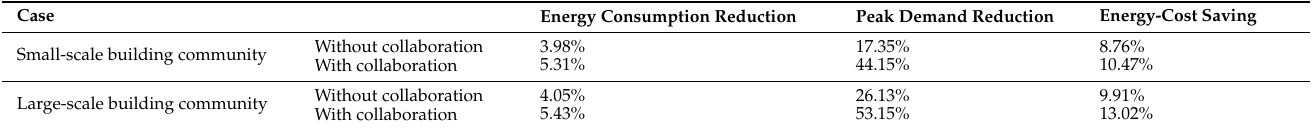
Table 5. The comparison of cost-saving percentages for different types of